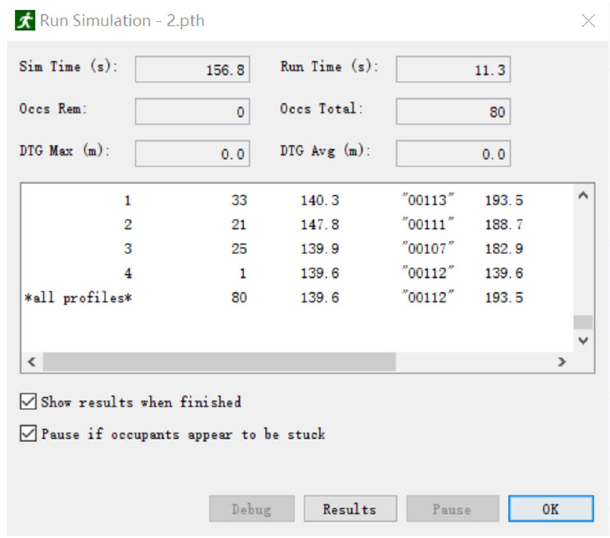
Figure 20. Total evacuation time (second simulation).